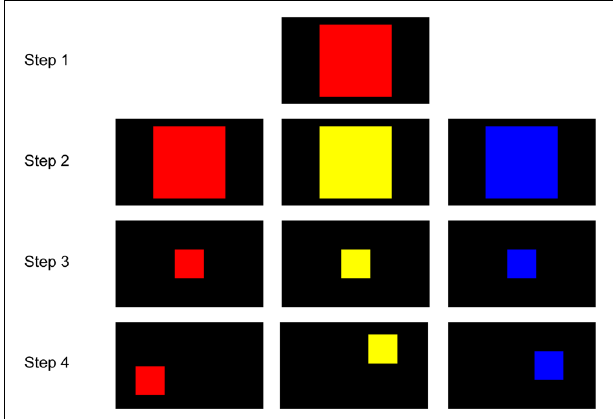
FIGURE 2 | Steps for touch training. In Step 1, the marmosets touched any part of a large red square (500 pixels × 500 pixels) on the screen to receive a reward. In Step 2, the color of the square was randomly set to red, yellow, or blue. In Step 3, the size of the square gradually decreased to the final size (200 pixels × 200 pixels). In Step 4, the location of the square varied from trial to